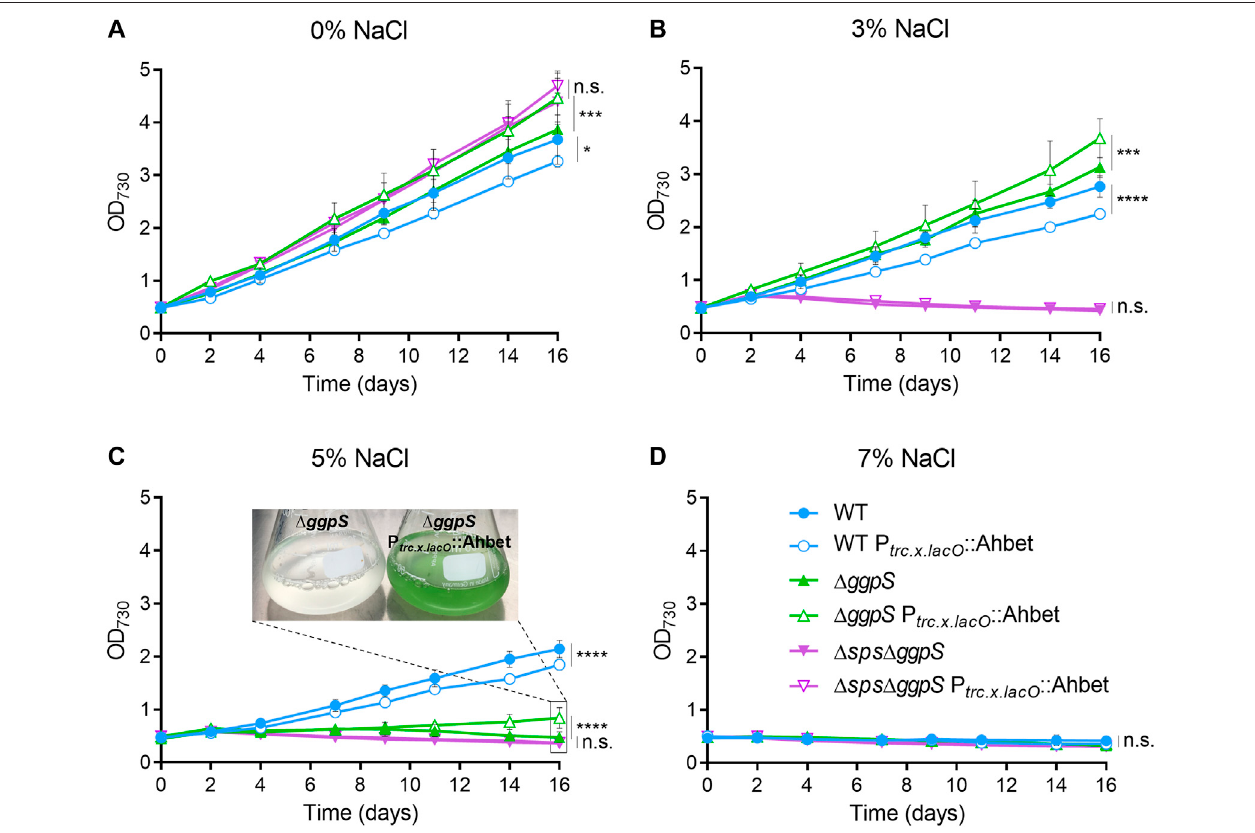
FIGURE6| Growthof Synechocystis wild-type(WT), Δ ggpS ,and Δ sps Δ ggpS withoutorwiththeGBdevice(P trc.x.lacO ::Ahbet).CulturesweregrowninBG11 (A) or BG11supplementedwith3% (B) ,5% (C) ,or7% (D) (wt/vol)NaCl,at30 ° Cwithorbitalshaking(150 rpm)undera12 hlight(25 μ E/m 2 /s)/12 hdarkregimen.Growthwas monitored by measuring the optical density at 730 nm (OD 730 ). Error bars correspond to standard deviations from at least three biological replicates with technical duplicates.Statisticalanalysiswasperformedusing two-way ANOVA. Statisticallysigni fi cantdifferences areidenti fi ed: ****( p ≤ 0.0001), ***( p ≤ 0.001), *( p ≤ 0.05), and n.s. (not signi fi cant). In Figure 6C , the liquid cultures of Synechocystis Δ ggpS (left) and Δ ggpS P trc.x.lacO ::Ahbet (right) , in BG11 supplemented with 5% NaCl after 16 days of cultivation, are